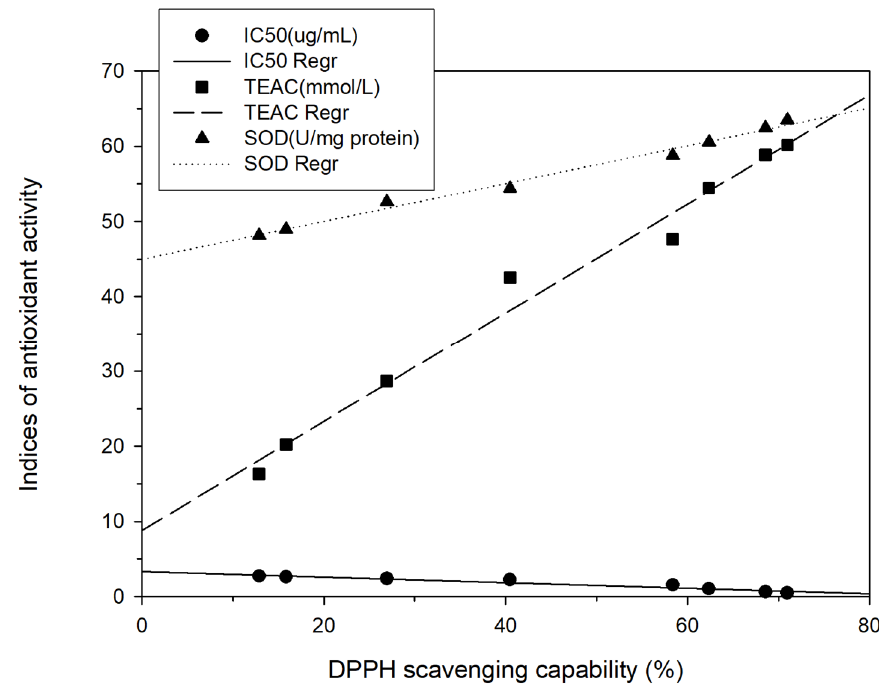
Figure 4. Correlation between TEAC (mmol/L) and SOD (U/mg protein) and between DPPH scavenging capability (%). Each test was performed in triplicate, and results are expressed as the average of three measurements ± standard deviation. The scale of error bar is too small to be visible.